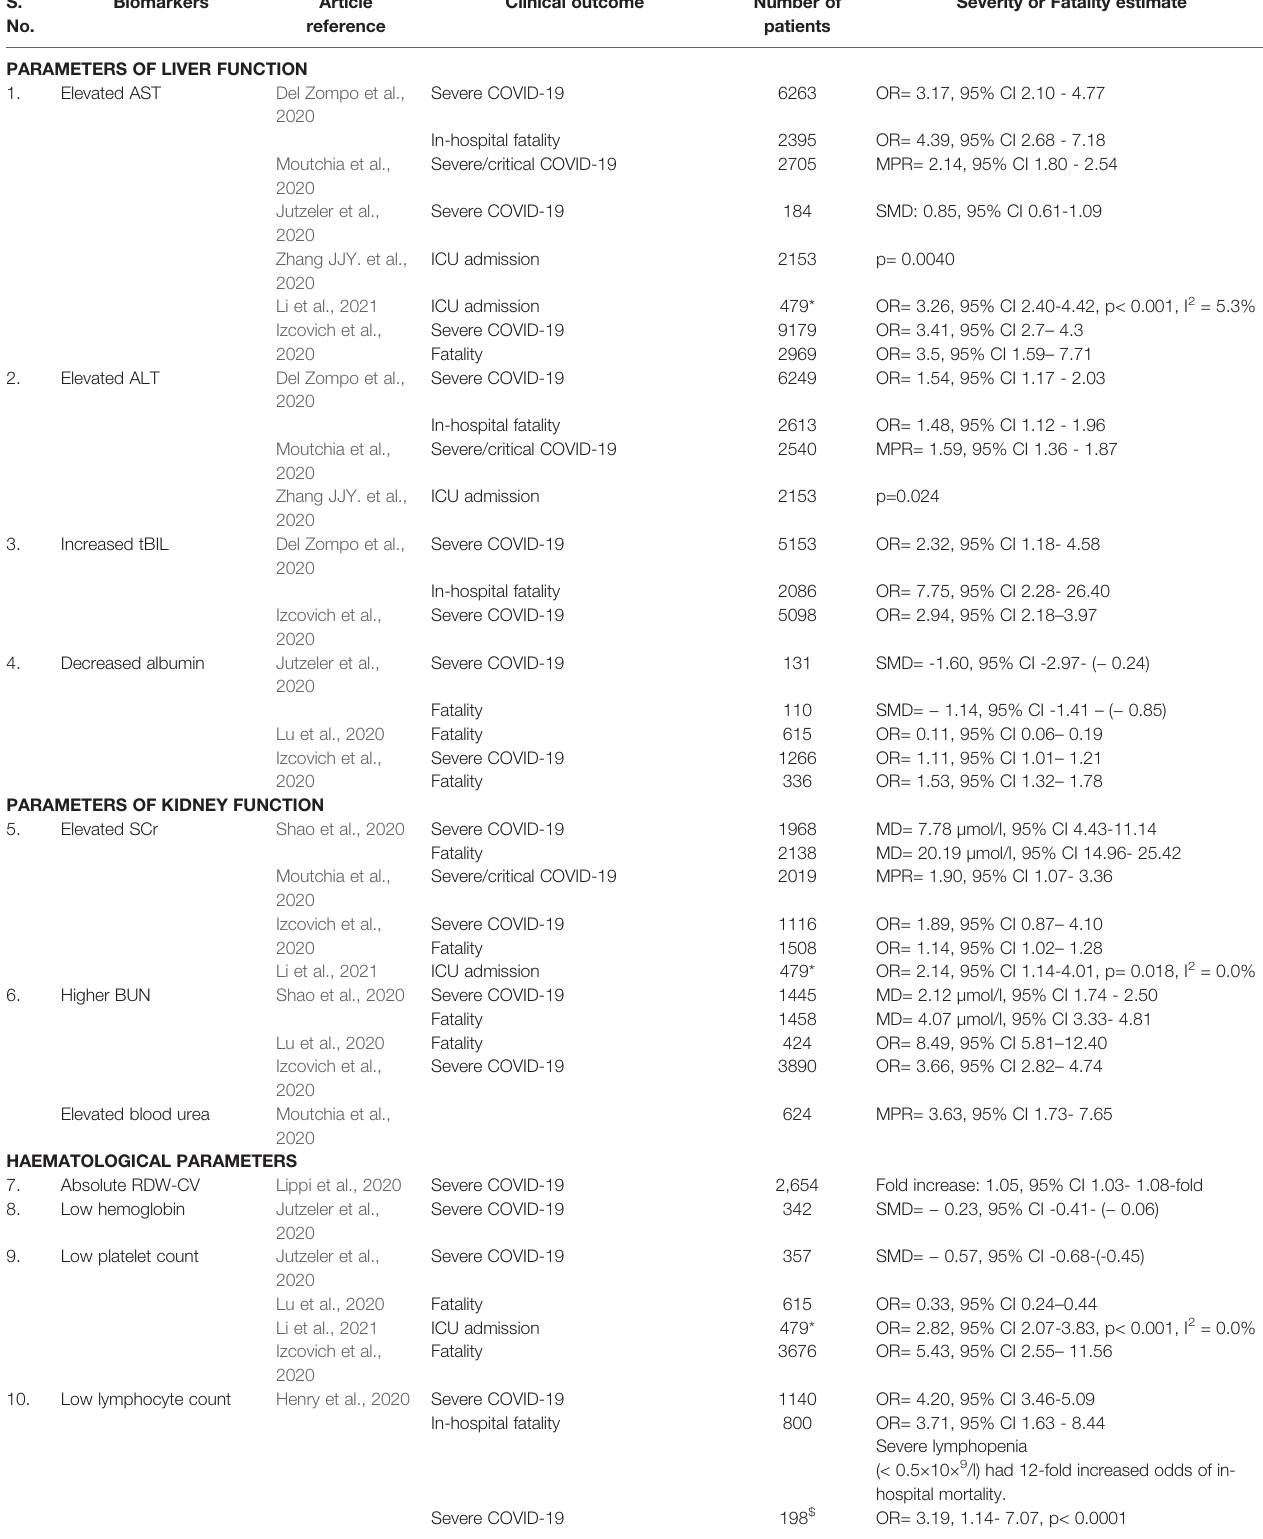
TABLE 2 | Putative independent predictors of COVID-19 adverse prognosis, severity or mortality. S.